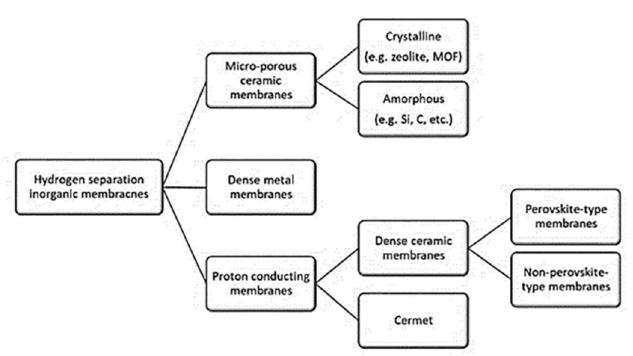
Figure 25. Membrane reactors based on their different properties. Reprinted with permission [37]. Table 10. Hydrogen permeating through Pd membrane before and after ammonia decomposing at different temperatures. Reprinted with permission [36].